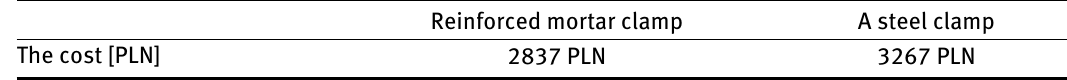
Table 2: Values for the criterion: costs of the implementation of pillar reinforcement (own studies)